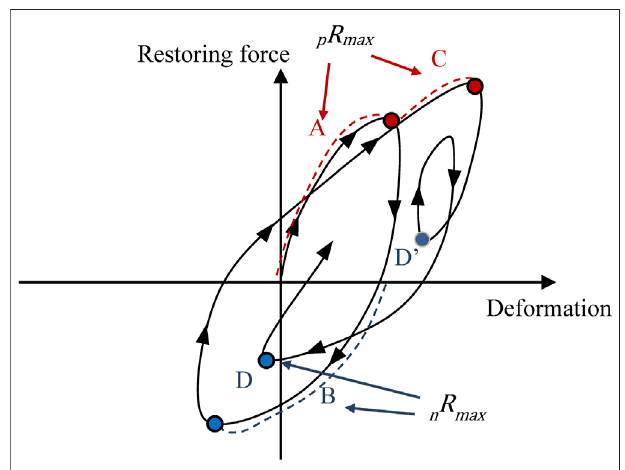
FIGURE 2 | Update procedure for the maximum amplitude of restoring force R max